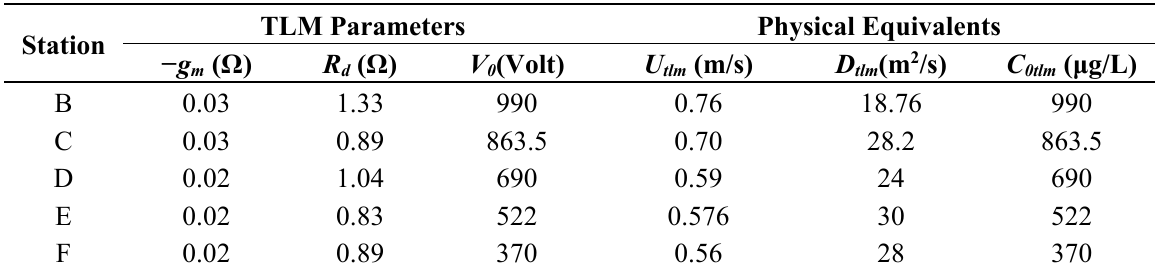
Table 4. Optimized TLM parameters and their physical